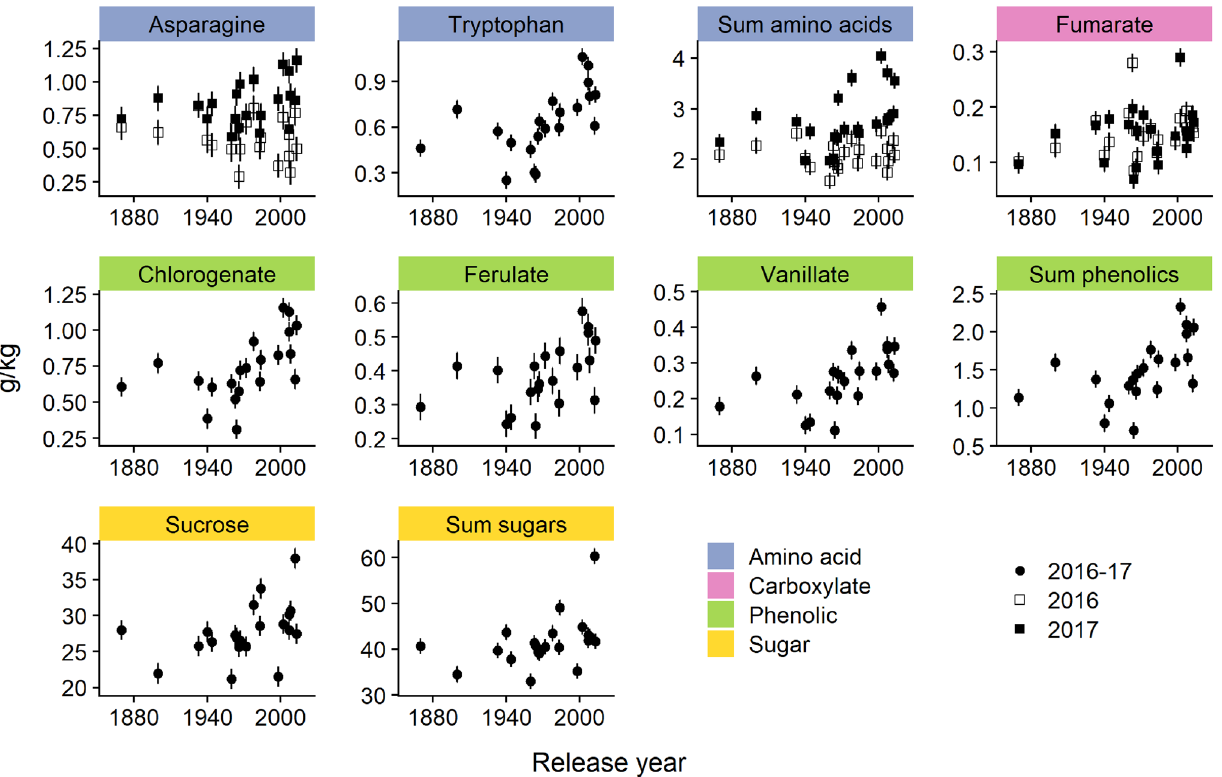
Figure 2. Scatter plots of cultivar year of introduction for metabolites that showed significant changes by release year (as reported in Table 3). Where the harvest year × release year interaction was not significant, each point represents the least squares mean of a cultivar or landrace across two harvest years (2016–2017); where the harvest year × release year interaction was significant least squares mean of a cultivar or landrace are shown for 2016 and 2017 separately; error bars show standard error; plot generated using the ‘ggplot2’ and ‘cowplot’ packages in R 38,40,41